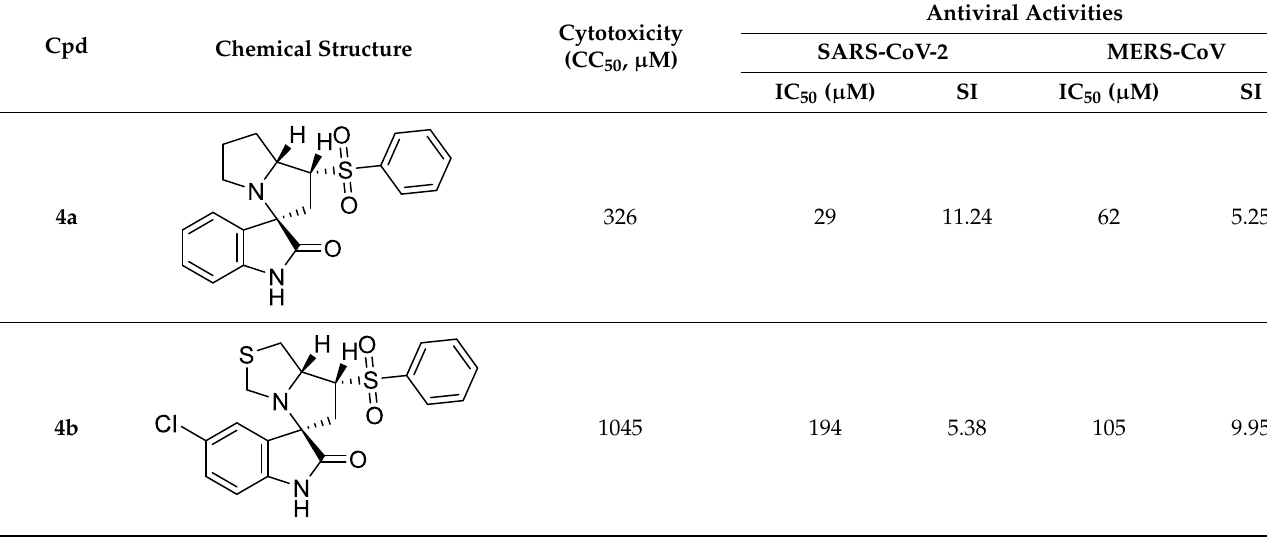
Table 1. Chemical structures, cytotoxicity, antiviral activities of the tested compounds against SARS-CoV-2 and MERS-CoV as determined by MTT and plaque reduction assay, respectively. Cpd Chemical Structure Cpd